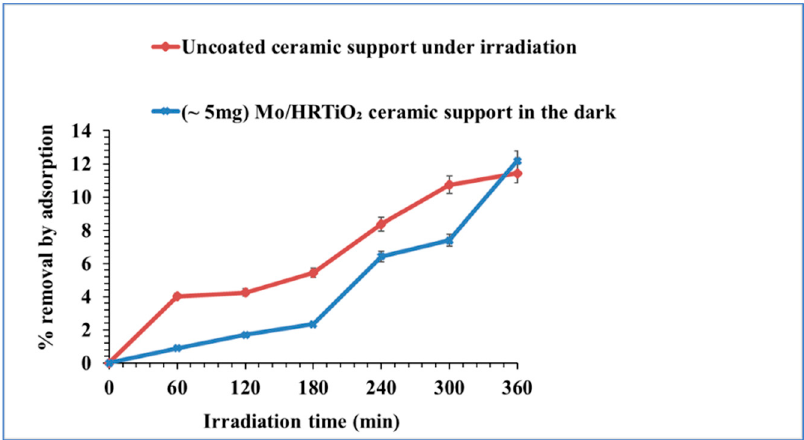
Figure 19. Dark effect with ~5 mg Mo/HRTiO 2 on ceramic, and test effect with uncoated ceramic under UV irradiation over initial 5 mg/L IBU removal.